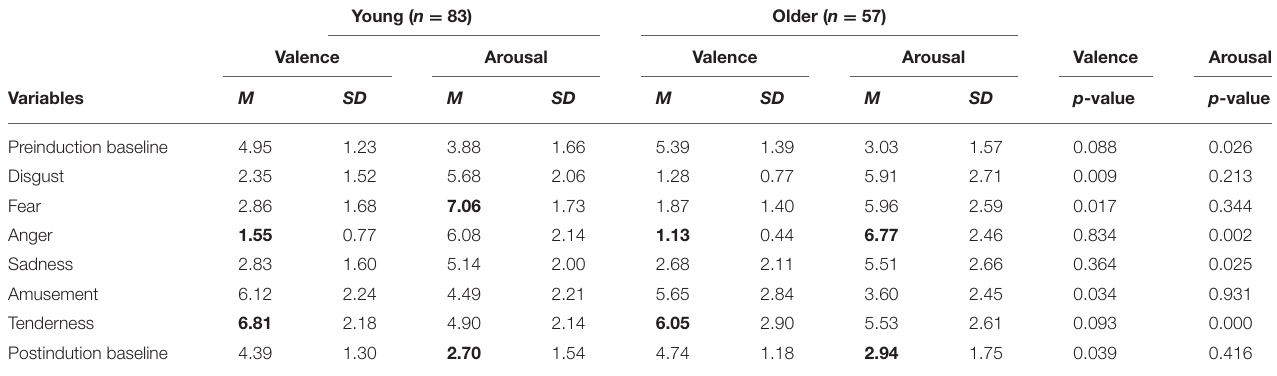
TABLE 3 | Valence and arousal of emotional target categories and baseline category.